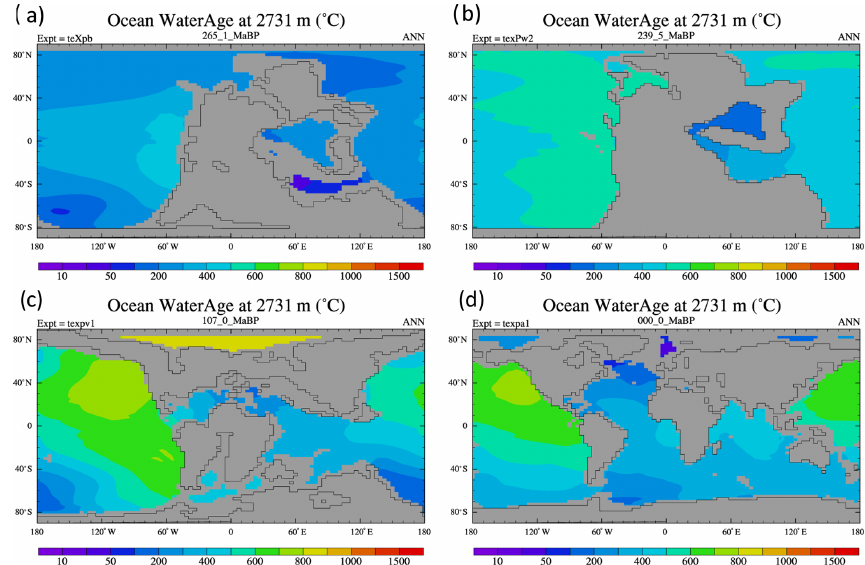
Figure 9. Modelled age of water tracer at 2731m for four different time periods: (a) 265Ma, (b) 240Ma, (c) 107Ma, and (d) 0Ma. Units are years.